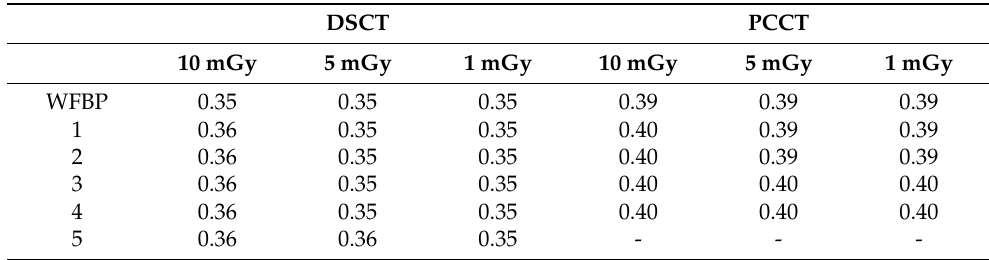
Table 6. F 50% (mm − 1 ) of PCCT and DSCT for virtual monoenergetic acquisition for all reconstruction strength levels and for the three CTDI vol (1, 5, 10 mGy).